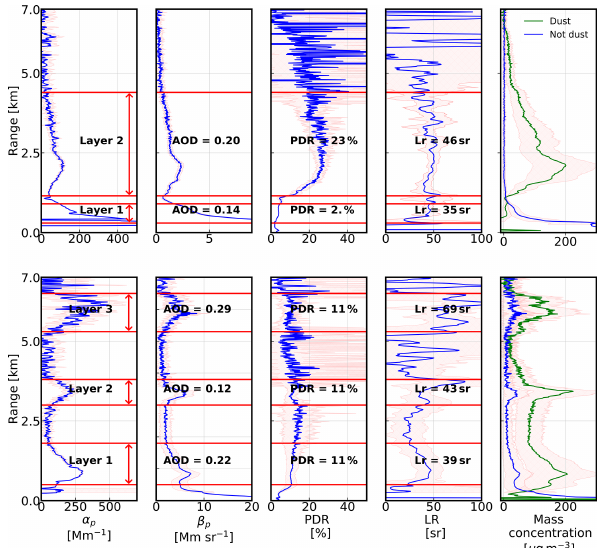
Figure 12. Warm sector. Optical properties and mass concentration estimates calculated from lidar signals. Top row: Watnall on 16 Oc- tober from 02:00 to 03:15UTC. Bottom row: Watnall on 16 October from 05:43 to 05:56UTC.